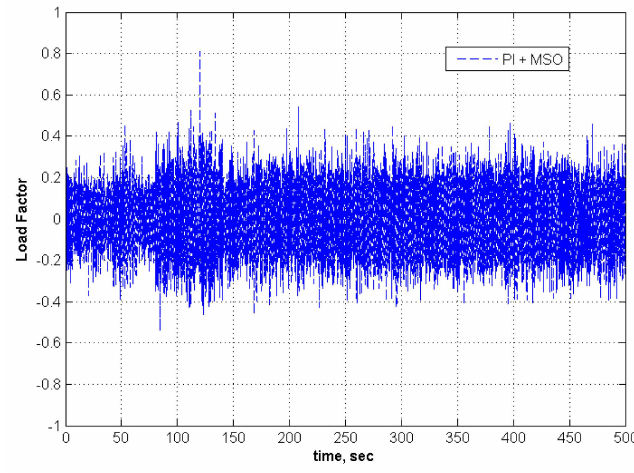
Figure 22. Load factor for 50% C m α in the